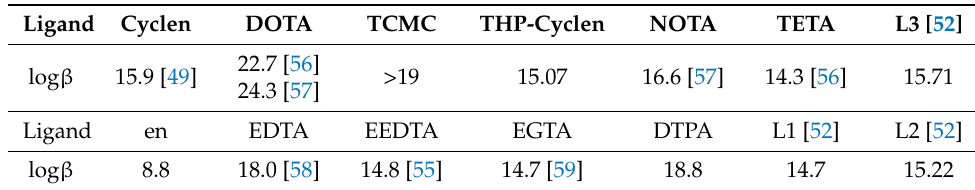
Table 2. Stability constants for some Pb–L